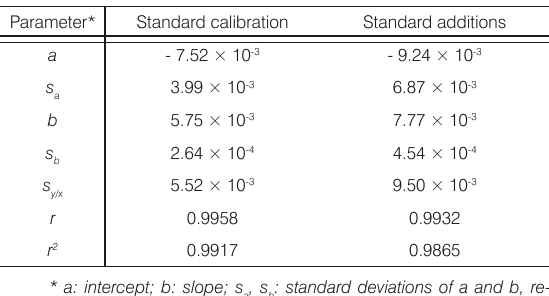
Table 2. Values of the parameters calculated for the standard cali- bration and the standard additions regression lines (the least squares method was the one applied).